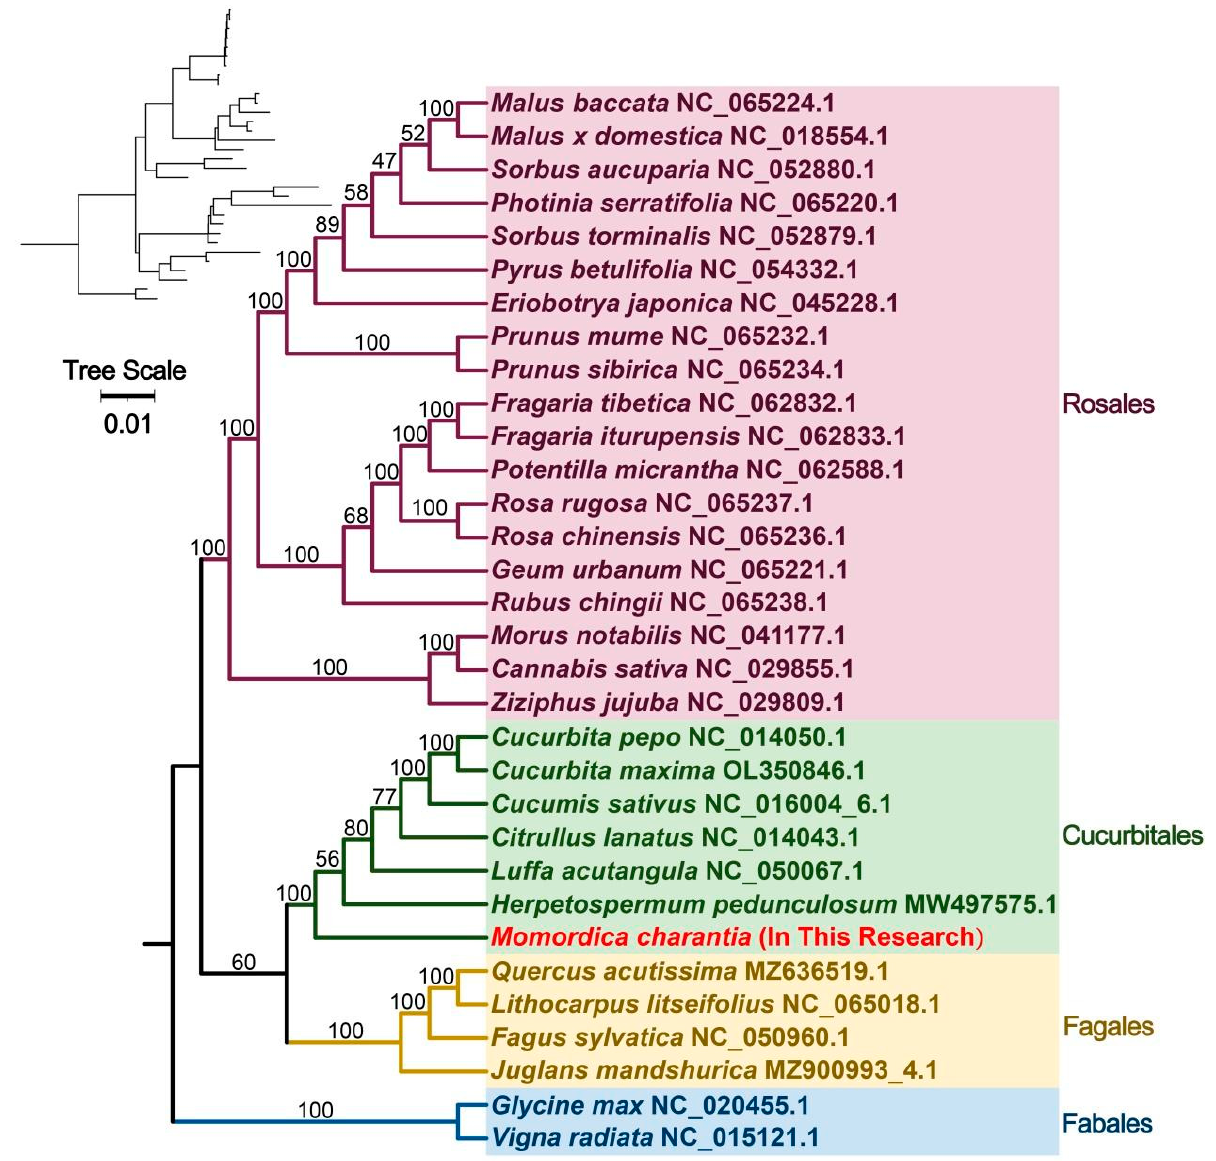
Figure 5. Phylogenetic relationships of bi tt er gourd.